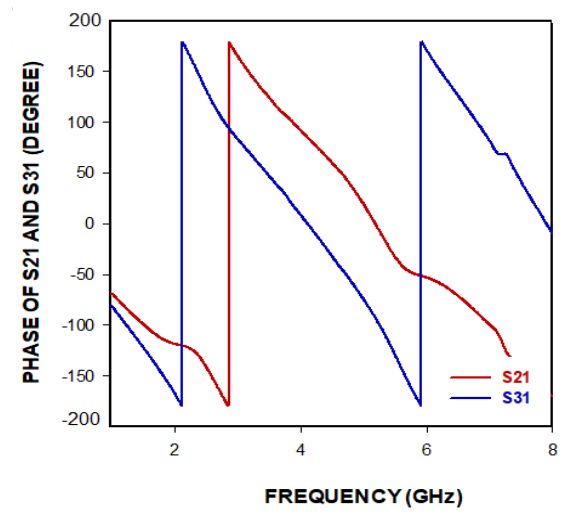
Fig.5. Proposed dual-band patch coupler design Table 2. Dimensions of the proposed dual-band patch coupler Parameters